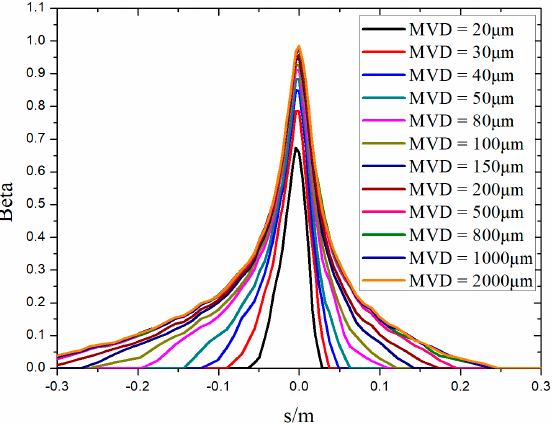
Figure 12. Comparison of the ice crystal collection coe ffi cients for di ff erent diameters.